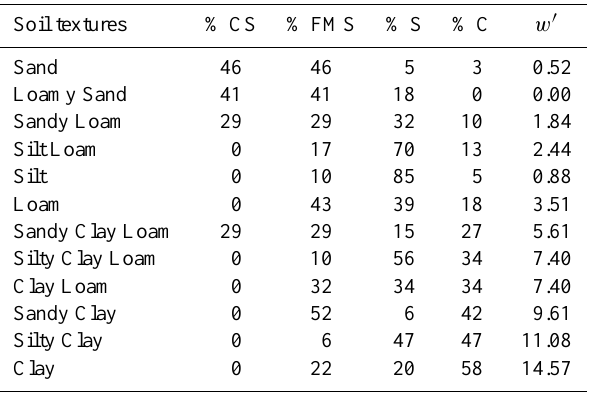
Table 1. Top soil texture classes from STASGO-FAO database, mass fractions (%) of coarse sand (CS), fine-medium sand (FMS), silt (S) and clay (C) for each soil texture class, and soil gravimetric water content threshold ( w 0 ). Sand is separated into coarse sand and fine-medium sand according to Tegen et al. (2002).